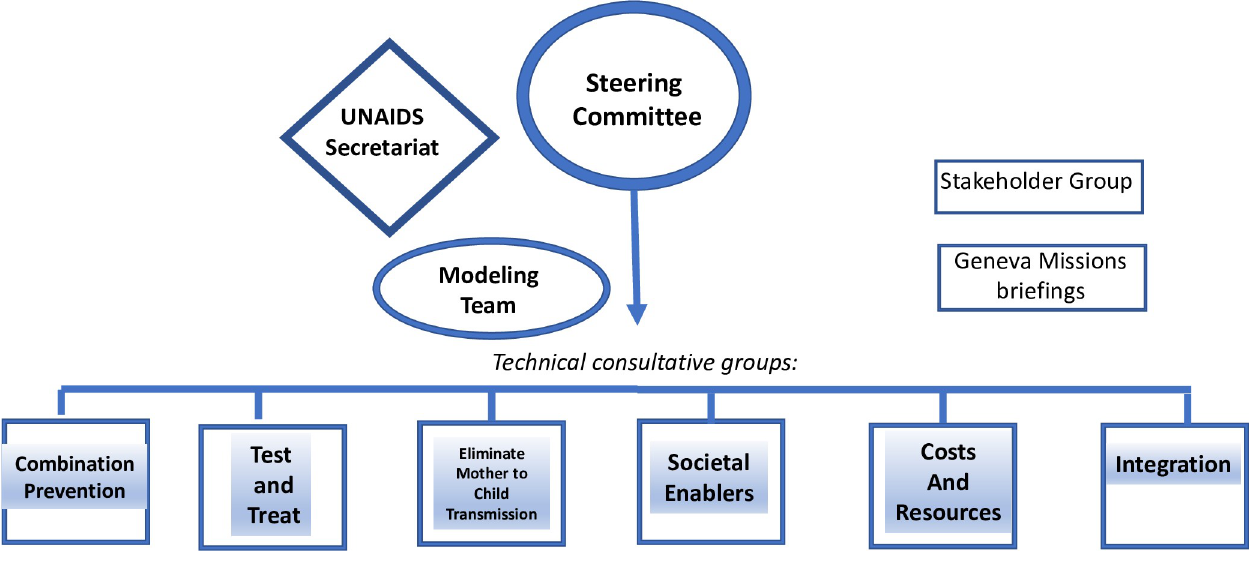
Fig 1. Setting AIDS 2025 targets—Functional